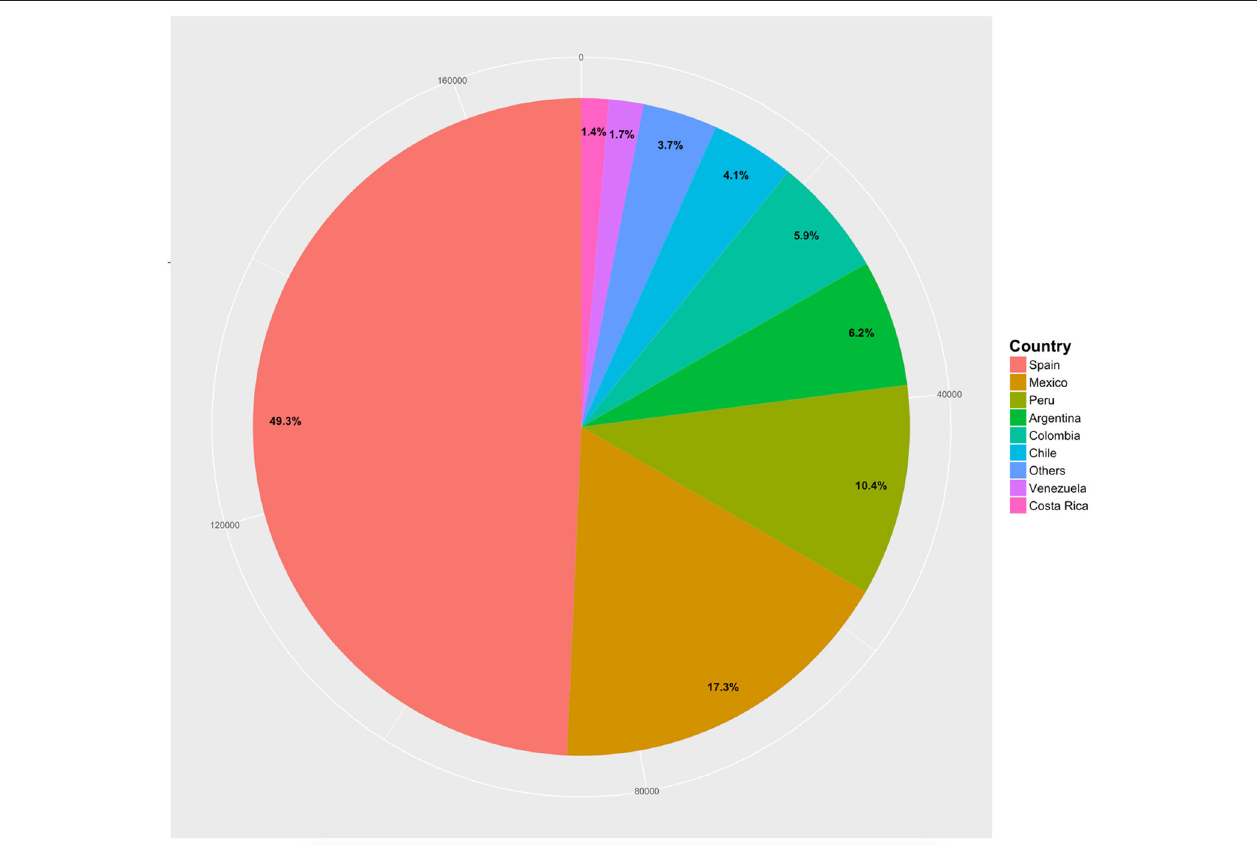
FIGURE 1 | Distribution of participants per country. Countries representing less than one percent of the data were combined into the ‘Others’ category. These are: Panama (0.1%), Honduras (0.1%), Nicaragua (0.1%), Paraguay (0.2%), Bolivia (0.2%), Cuba (0.2%), El Salvador (0.2%), Dominican Republic (0.2%), Guatemala (0.4%), Uruguay (0.9%), and Ecuador (0.9%).